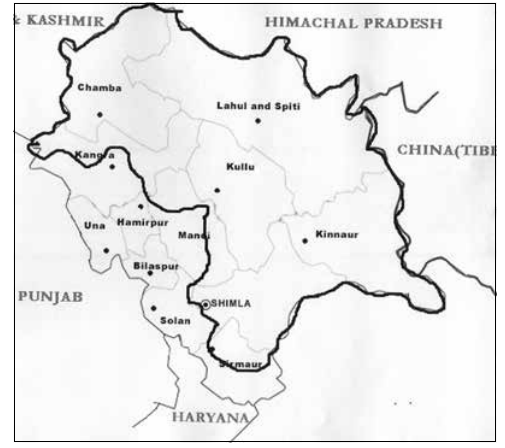
Figure-2: Map depicting the breeding tract of hill cattle of Himachal PCA